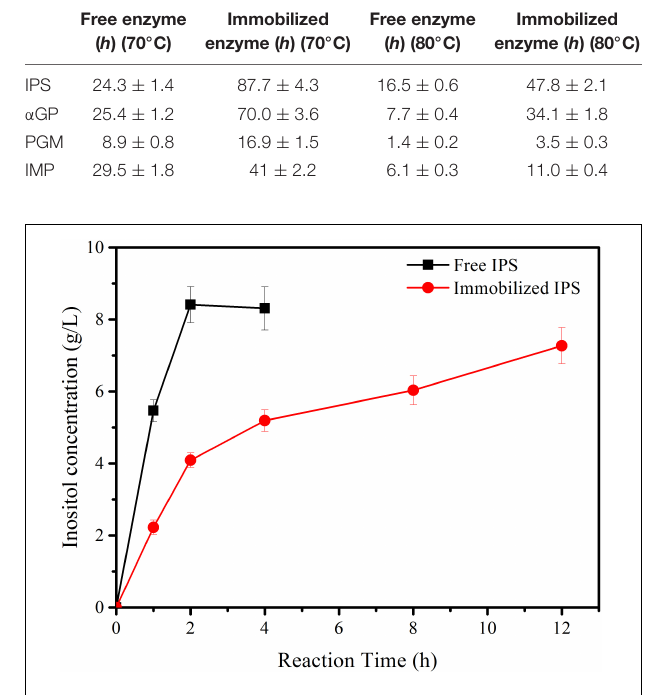
FIGURE 3 | The inositol production as a function of reaction time catalyzed by the reaction systems containing free and immobilized IPS.